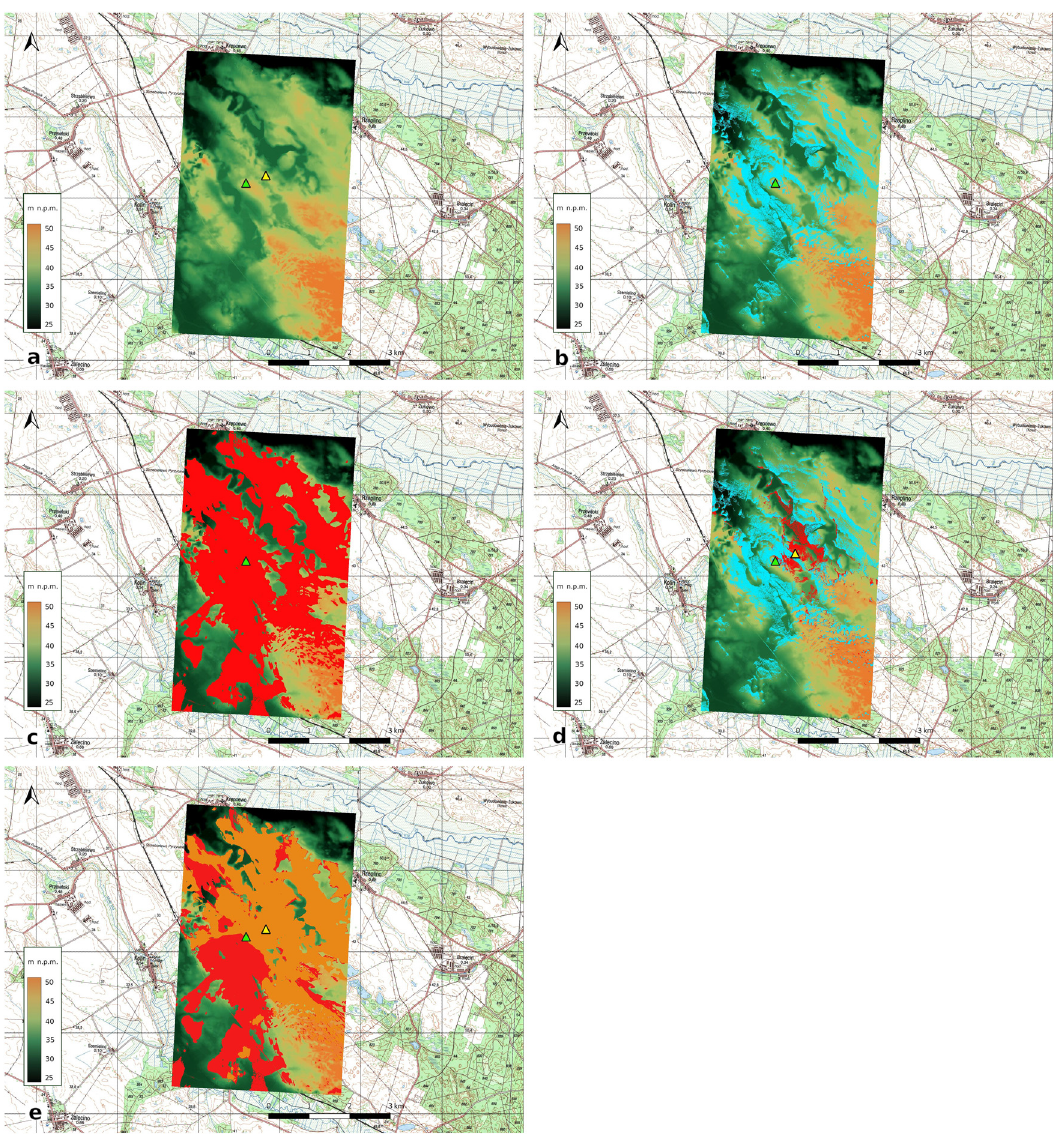
Figure 6: The point selected as optimal near the tomb at Kr ę pcewo [ yellow triangle ] in terms of visibility from this location and this location from the surrounding area: location of the point [ green triangle ] ( a ) , the area visible from the point ( b ) , the area from which the point is visible ( c ) , the juxtaposed areas visible from the point and the tomb at Kr ę pcewo ( d ) and the juxtaposed areas from which the point and the tomb at Kr ę pcewo are visible ( e ) ( M. Schiller )